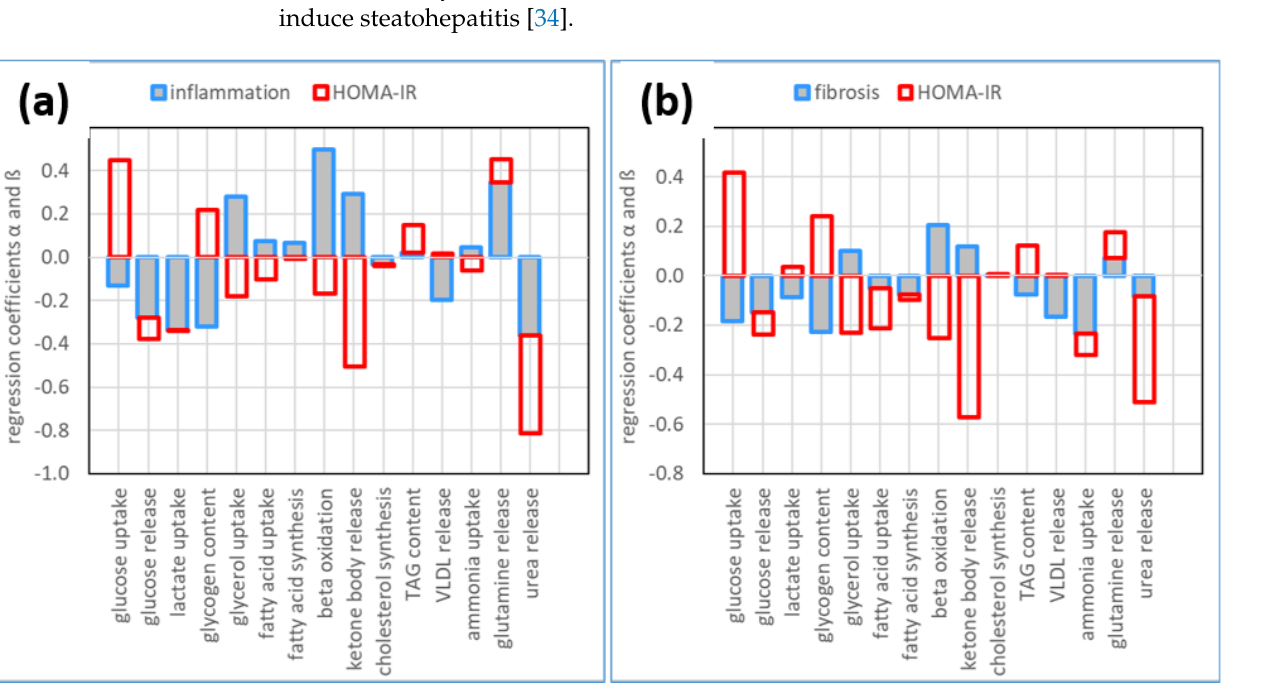
Figure 7. Association strength of NASH and IR with metabolic changes of the liver. The association strength was quantified by the normalized regression coefficients α and β in Equation (1). ( a ) Association strength if the severity of NASH and IR is measured by inflammation grading and HOMA-IR; ( b ) Association strength if the severity of NASH and IR is measured by fibrosis grading and HOMA-IR.